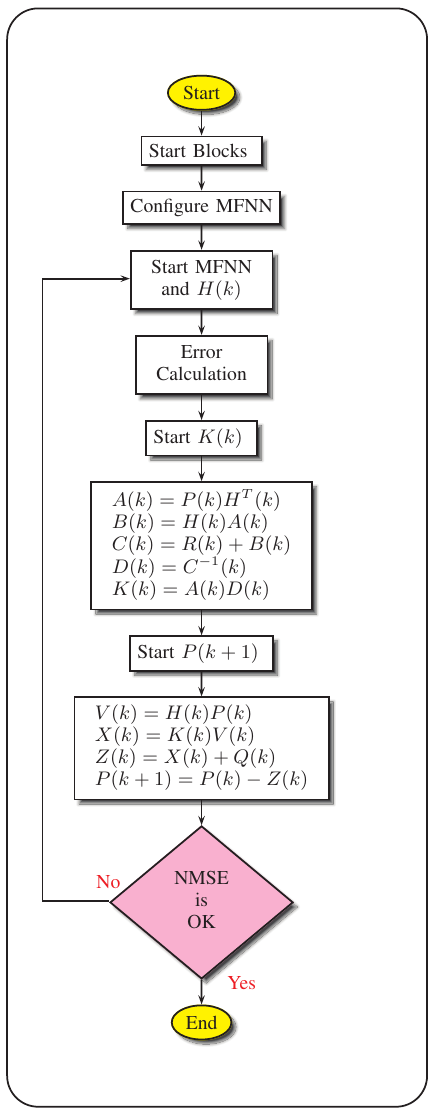
Figure 13. Training algorithm performed by ARM